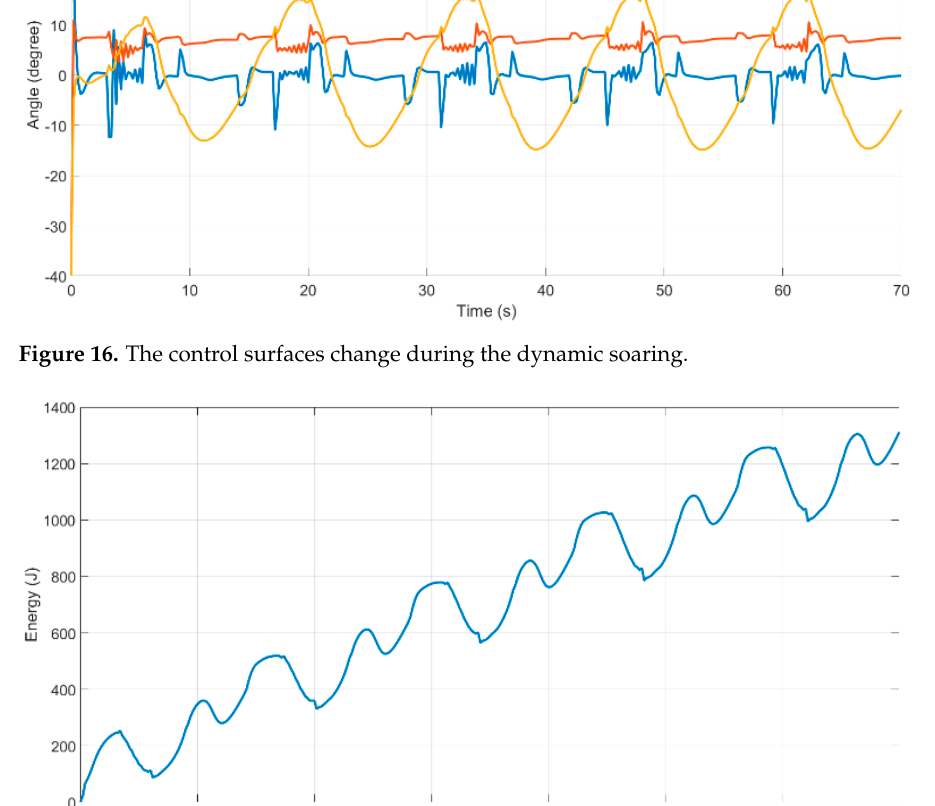
Figure 16. The control surfaces change during the dynamic soaring.